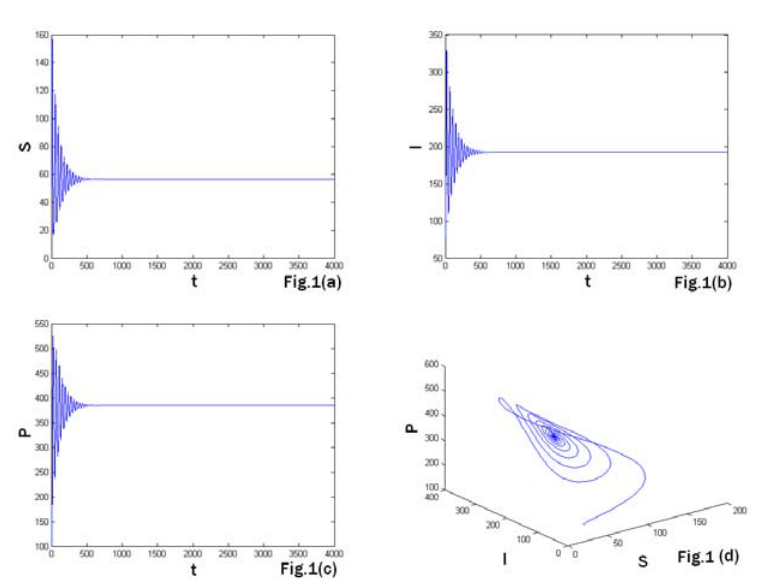
Figure 1. Time evolution of all the population for the model (1.2) with τ = 0 and initial value (50,80,100). (a), (b) and (c) are S , I and P versus t , respectively. And (d) is the projected S − I − P phase